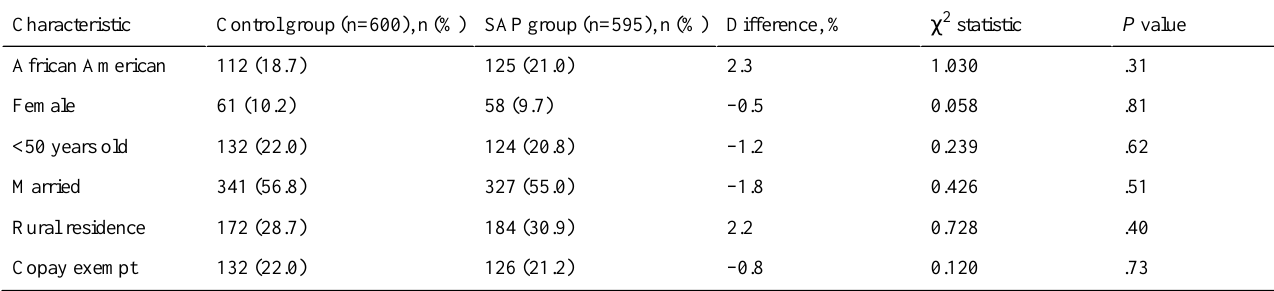
Table 1. Baseline characteristics of patients registered in the patient portal in 2016 who had not yet used secure messaging, with comparisons between the Supported Adoption Program (SAP) and control